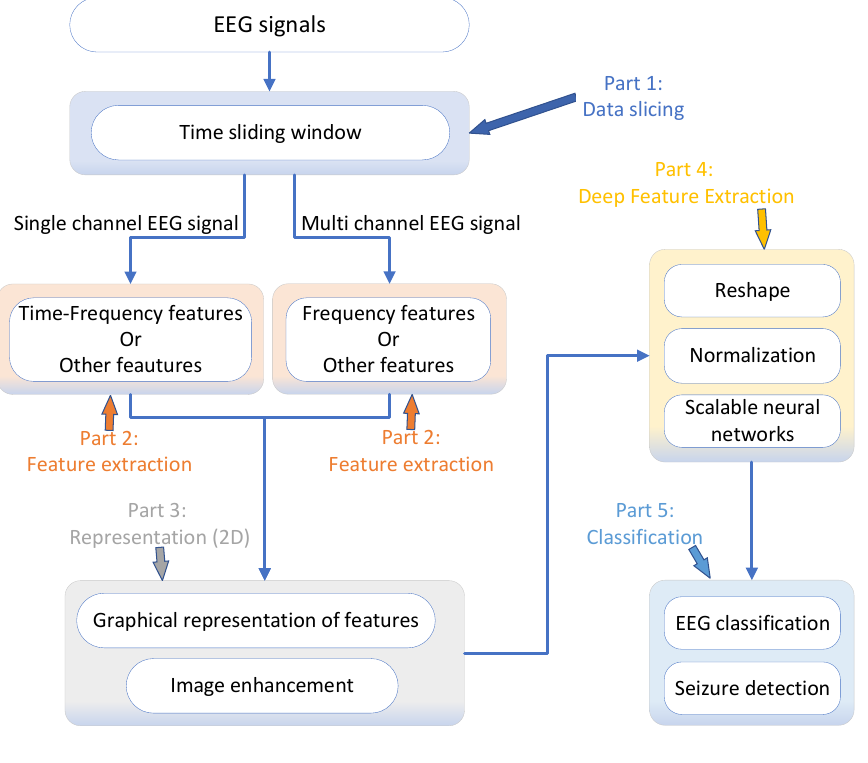
Figure 1. The main parts of the proposed